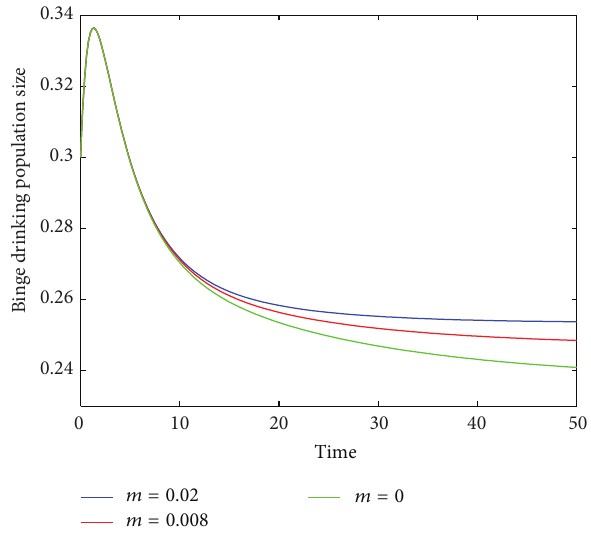
Figure 6: Variations of binge drinking population with time for different values of 𝑚